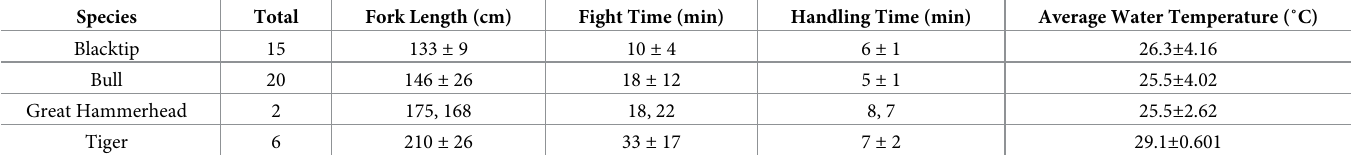
Table 1. Summary of catch information for each species, including total number of individuals, average ± standard deviation for fork length (cm), fight time (min), handling time (min), and water temperature (˚C) calculated for blacktip, bull, and tiger sharks. Hammerheads are reported as raw values due to small sample size.